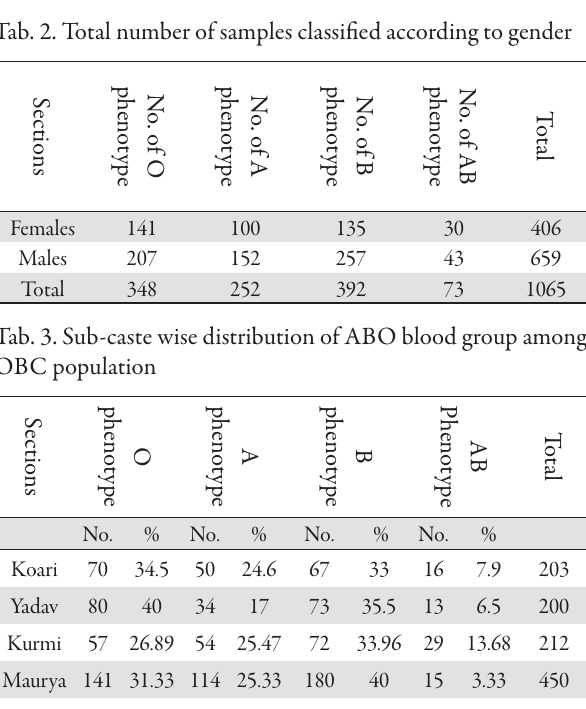
Tab. 2. Total number of samples classified according to gender